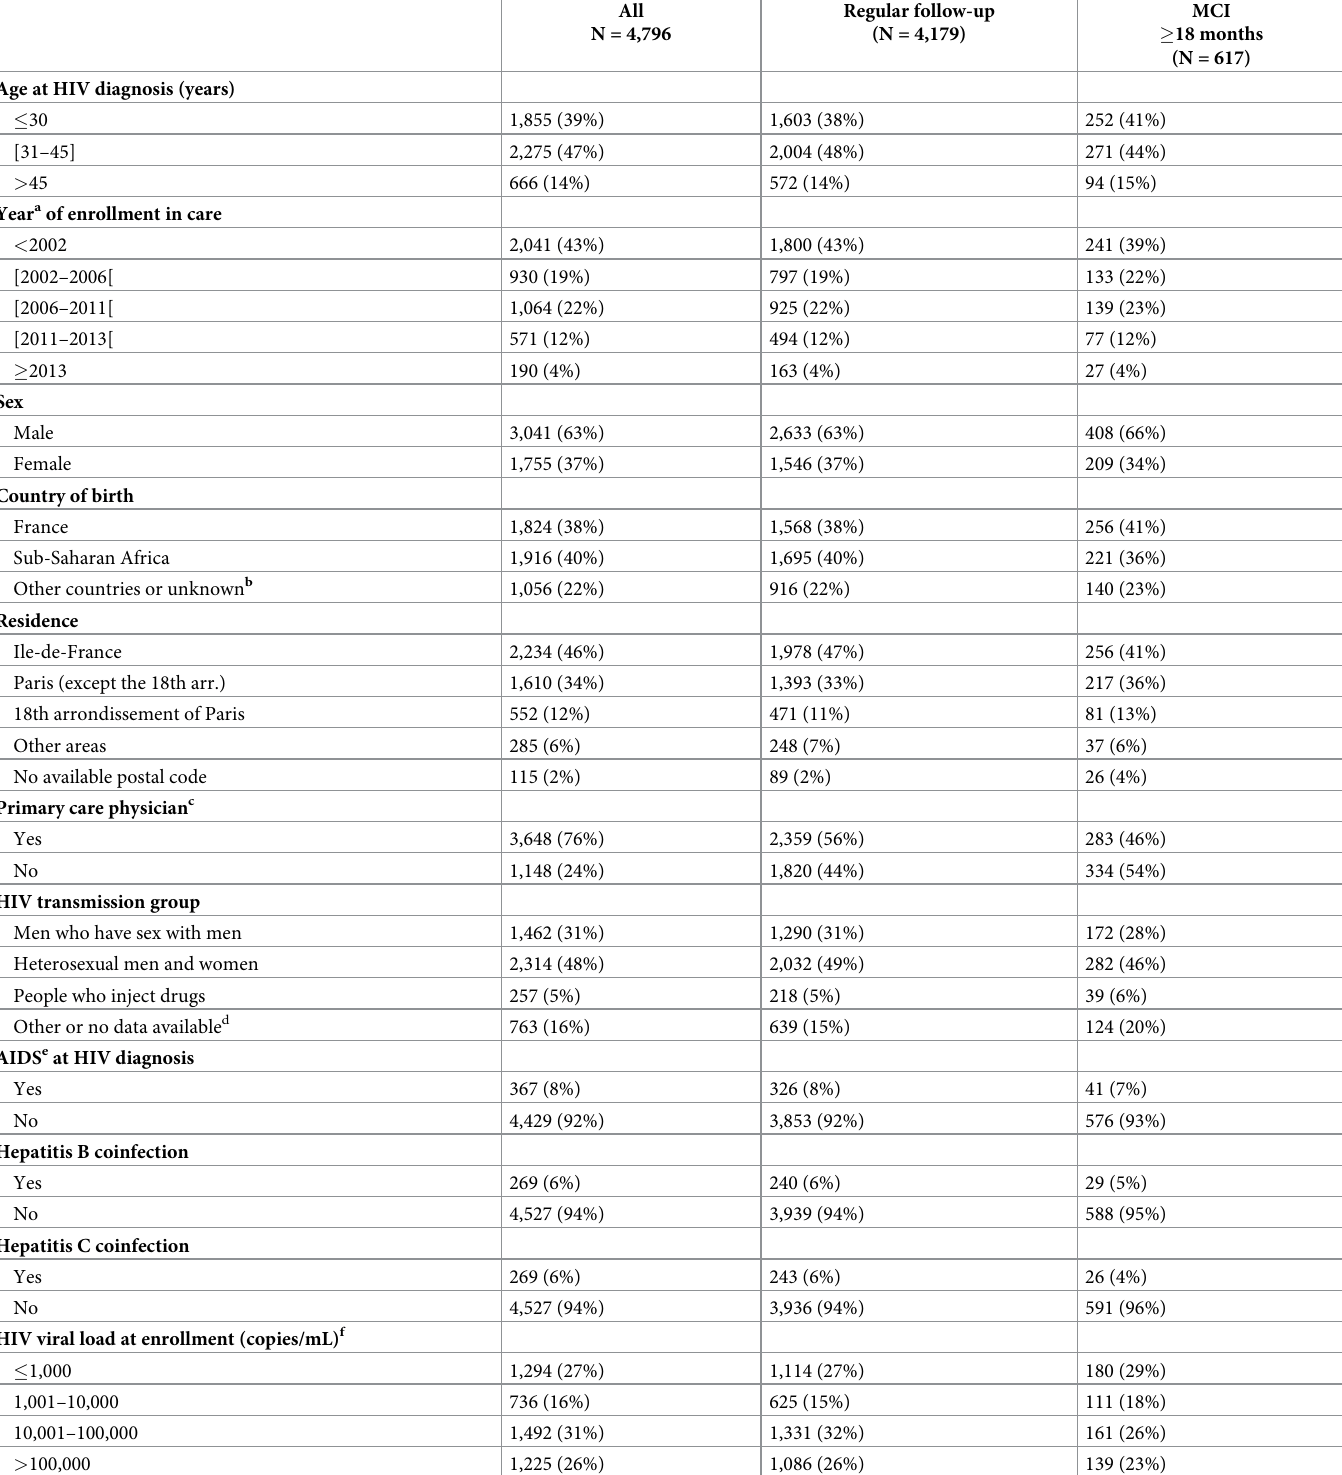
Table 1. Characteristics associated with Medical Care Interruption (MCI) at the time of HIV diagnosis of patients seeking HIV care in the infectious diseases department of the Bichat hospital, Paris, between January 2010 and May